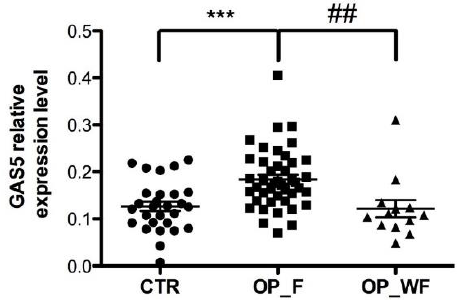
Figure 3. Serum expression level of GAS5 in OP patients with and without fragility fractures. The GAS5 expression level in the serum from 43 OP patients with fragility fractures (OP_F) was compared to 13 OP patients without fractures (OP_WF) and 28 healthy samples (CTR). The GAPDH mRNA level was used to normalize the relative amount of GAS5 and relative expression values are expressed as 2 − ∆ Ct . Statistical di ff erences between groups were analyzed using ANOVA with Tukey’s multiple comparison post-test analysis. Error bars indicate mean ± s.e.m. *** Represents a significant di ff erence between OP_VF and CTR ( p < 0.001); ## represents a significant di ff erence between OP_VF and OP_FF ( p < 0.01).